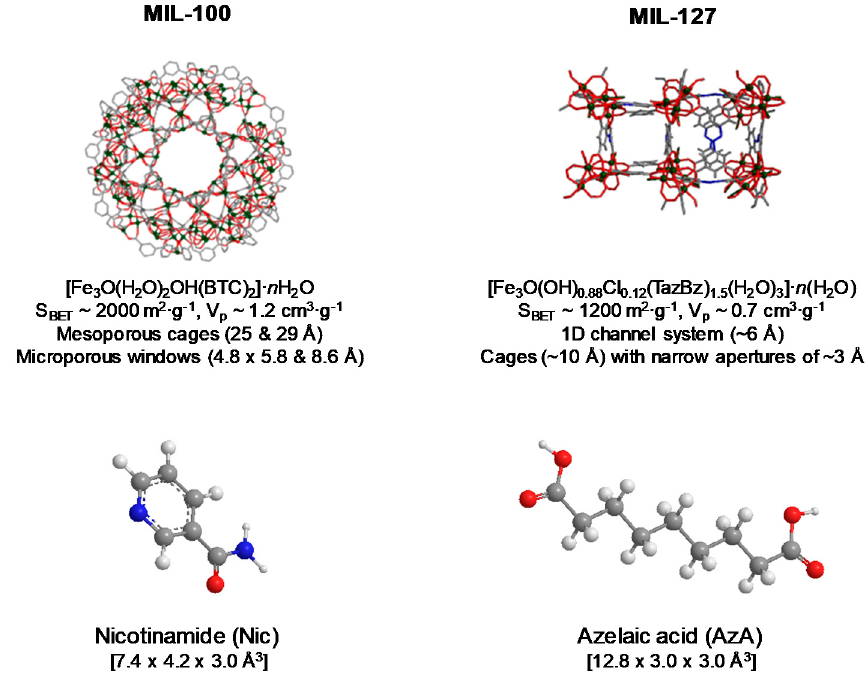
Figure 1. Schematic view of the structure of MIL-100 and MIL-127 (iron polyhedra, nitrogen, oxygen, and carbon are represented in green, blue, red, and gray, respectively; hydrogen atoms are omitted for clarity), their formulas, and the description of their structure and porosity. Nic and AzA molecules and their dimensions (size calculated from Vesta free software considering van der Waals radii) are also given.